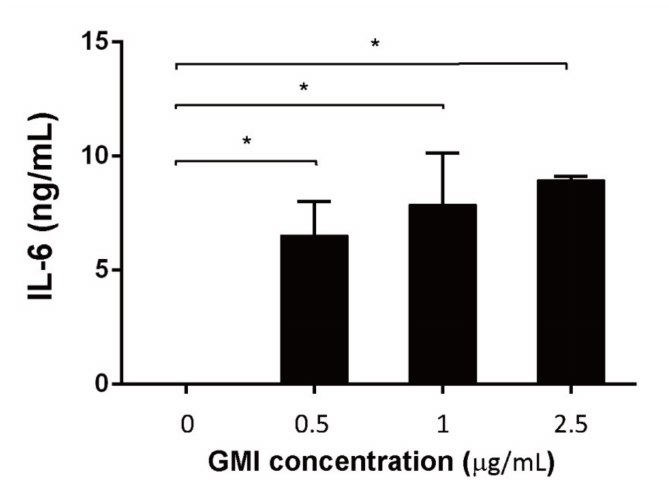
Figure 5. Expression of IL-6 by T cells after GMI treatment. T cells were cultured in the presence of GMI for 48 h. IL-6 in the culture medium was assayed by a CBA kit. The results were analyzed statistically with Student’s t -test. *: p <